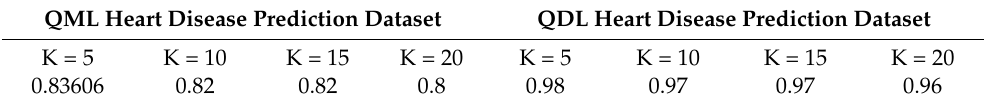
Table 7. K-fold Cross Validation. QML Heart Disease Prediction Dataset